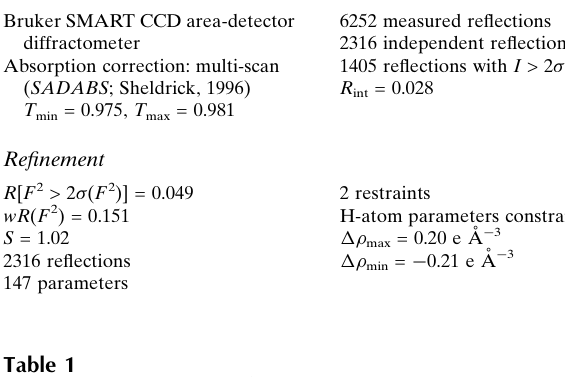
Hydrogen-bond geometry (A˚ , (cid:1)